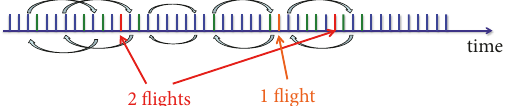
Figure 1: Illustration of the need to give access and flexibility to